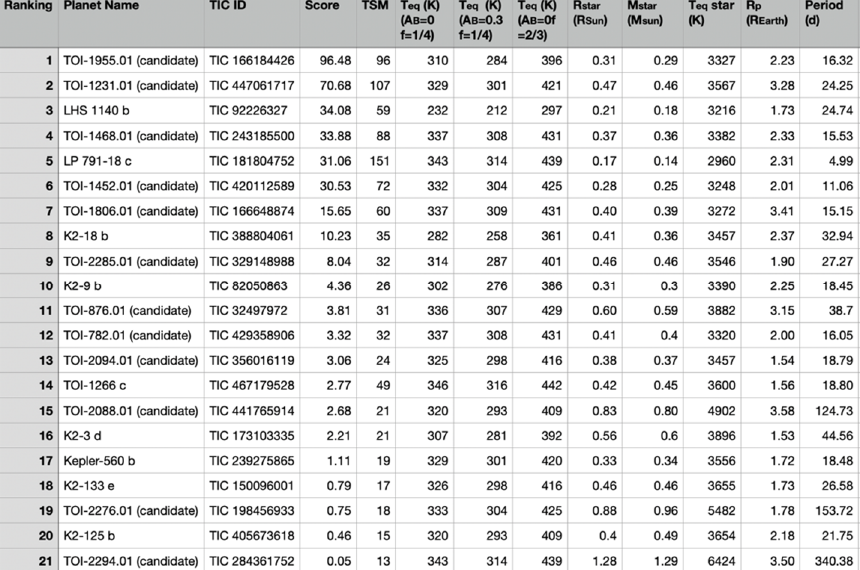
Figure 7. Temperate sub Neptune exoplanets suitable for atmosphere follow up. The planets are ranked by their position with respect to favorable atmospheric temperature and the Transmission Spectroscopy Measurement (TSM) (the blue region in Figure 6). A target with a median value fully within the favorable parameter range has a score = TSM. If the target is outside the favorable range, the target’s score gets down-weighted according to how far the target’s parameter’s median lies outside the favorable range. Quantitatively, score = TSM * f(Teq) * g(TSM). Here, the term f(Teq) = (320 K − T eq_low )/( T eq − T eq_low ) for T eq < 320 K. The term g(TSM) = (TSM − 12)/(x − 12) if TSM < x, 92 with x = 92 for tiny and small sub Neptunes (1.5 R Earth < R p ≤ 2.75 R Earth ), and x = 84 for large sub Neptunes 2.75 R Earth < R p ≤ 4 R Earth [147].